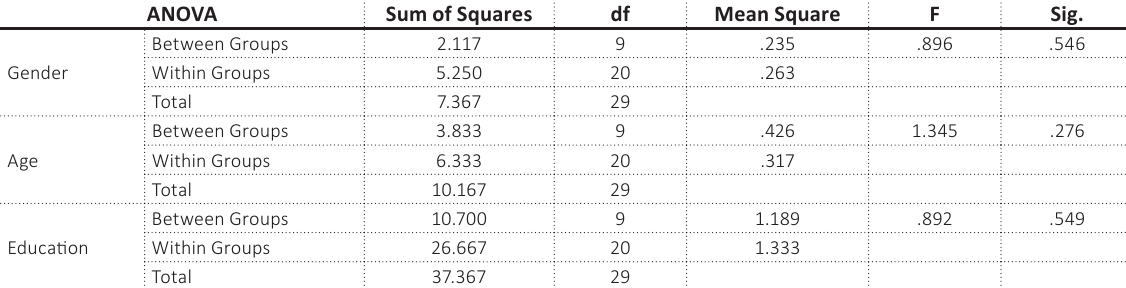
Table 3. ANOVA of purchase intention